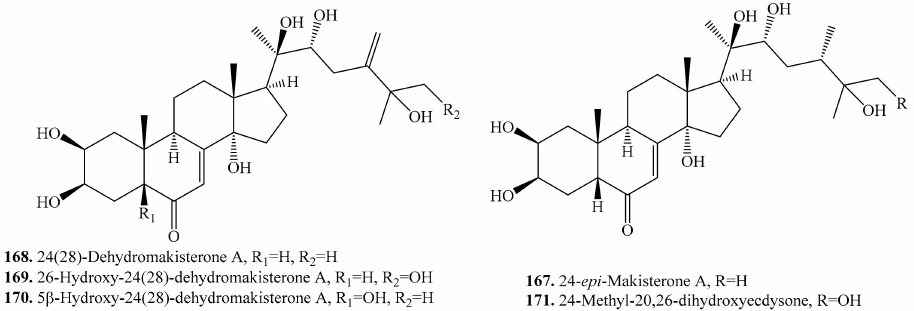
Figure 23. Structures of the C 28 -steroids isolated from quinoa.